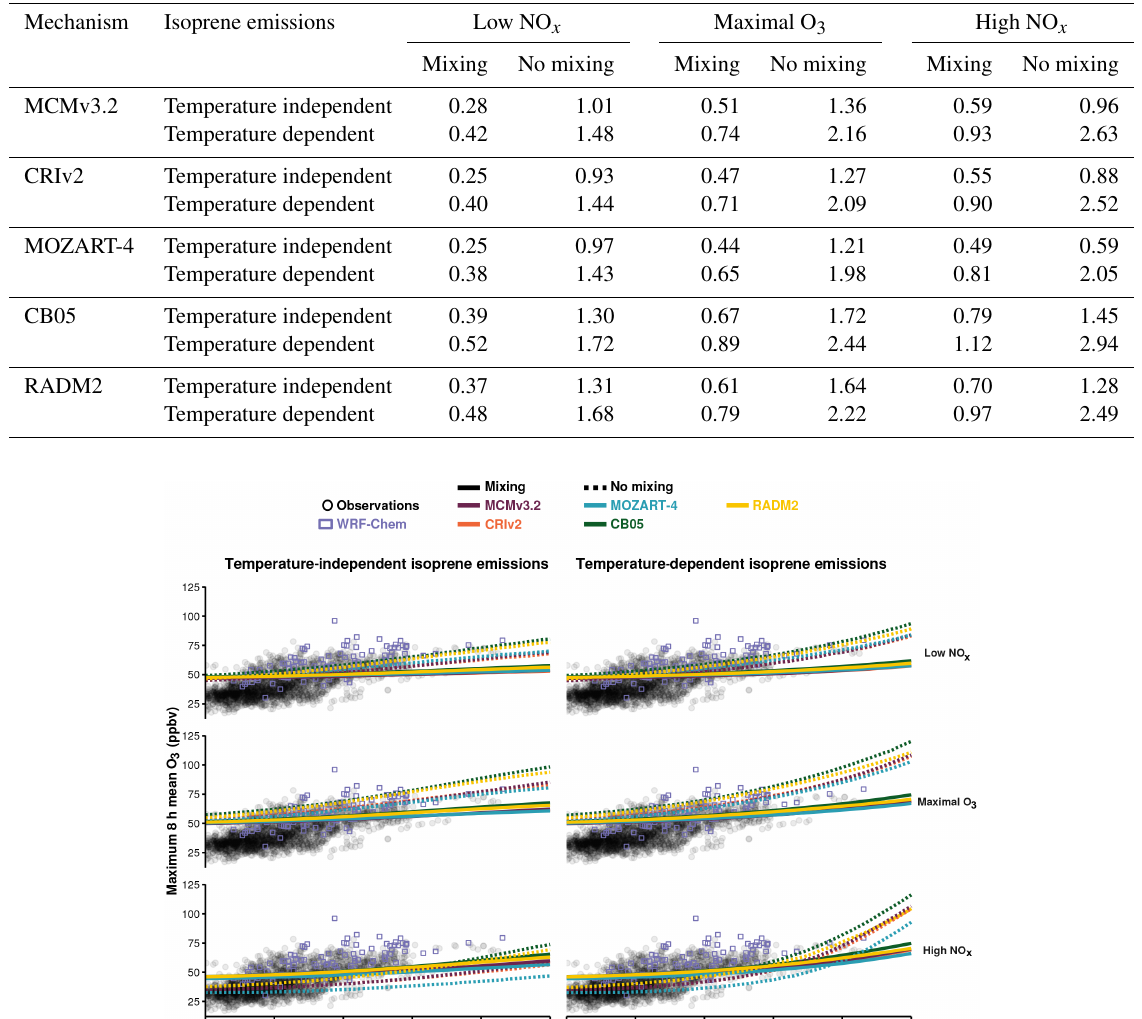
Table 3. Slopes ( m O , ppbv per ◦ C) of the linear fit to MDA8 values of ozone and temperature correlations in Fig. 5, indicating the 3 − T increase of MDA8 in ppbv of ozone per ◦ C. The slope of the observational data is 2 . 15ppbv ◦ C − 1 , and the slope of the WRF-Chem output is 2 . 05ppbv ◦ C − 1 .